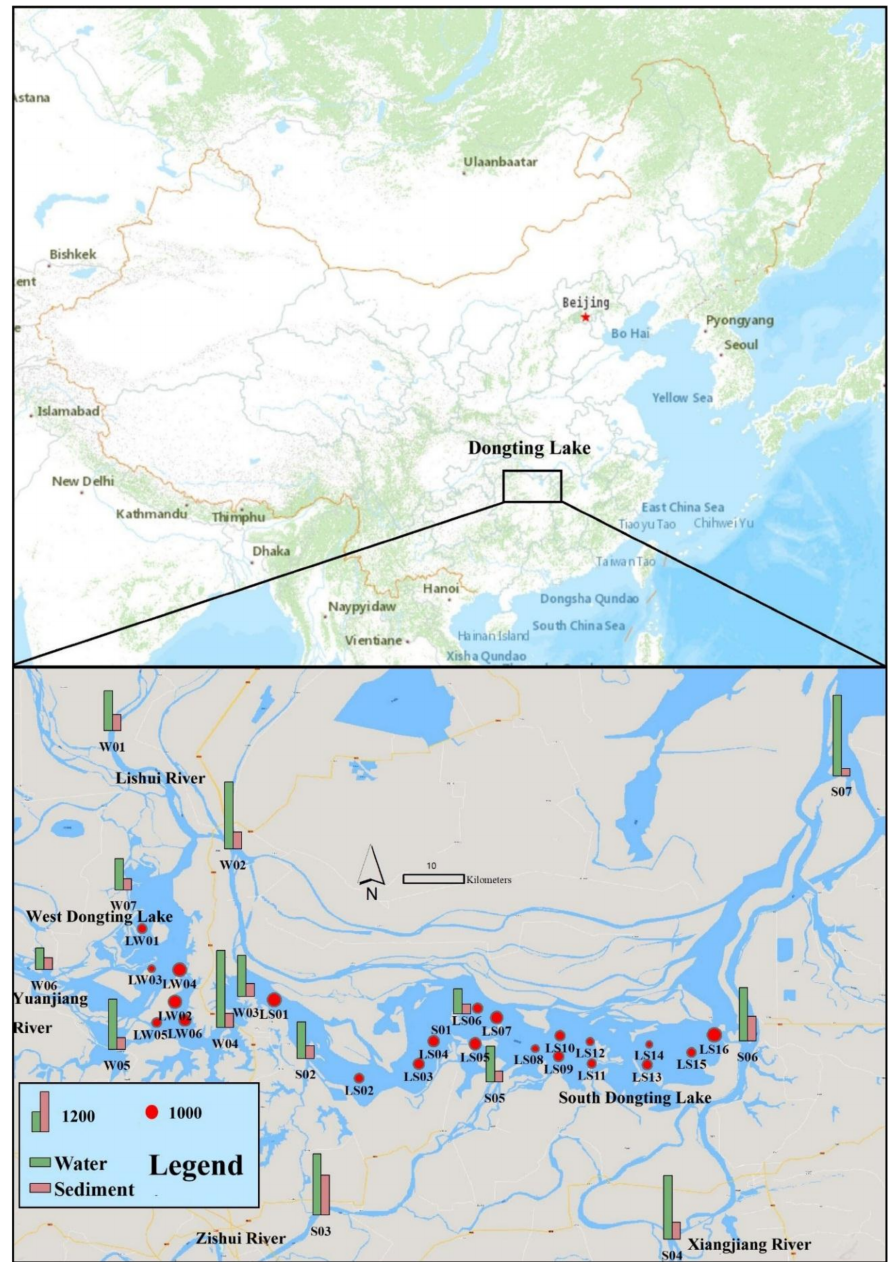
Figure 1. Geographic locations, sampling sites and microplastic abundance (The columns represent the lakeshore sites, and the pies represent the lake center sampling sites, and the units of microplastic concentration in water and sediment are items/m 3 and items/kg,